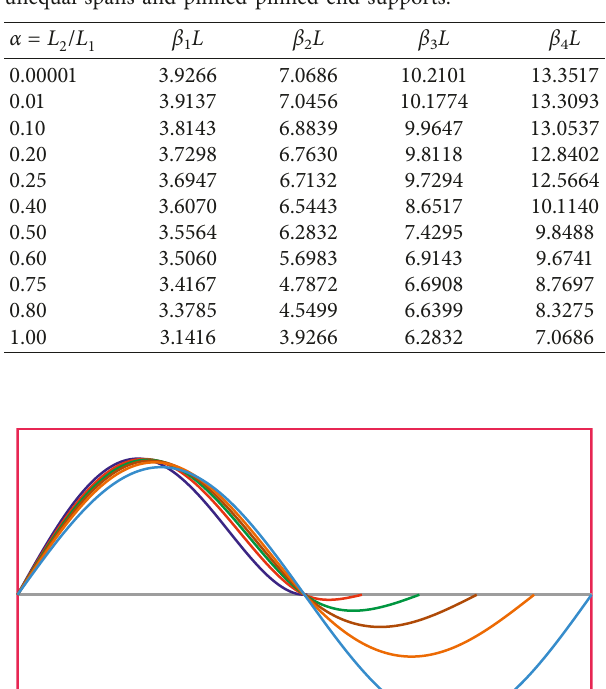
Table 4: Frequency parameters for continuous beams with two unequal spans and pinned-pinned end supports.